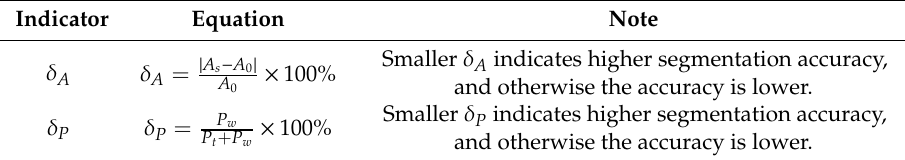
Table 1. Criteria for evaluating segmentation accuracy of watershed algorithm.